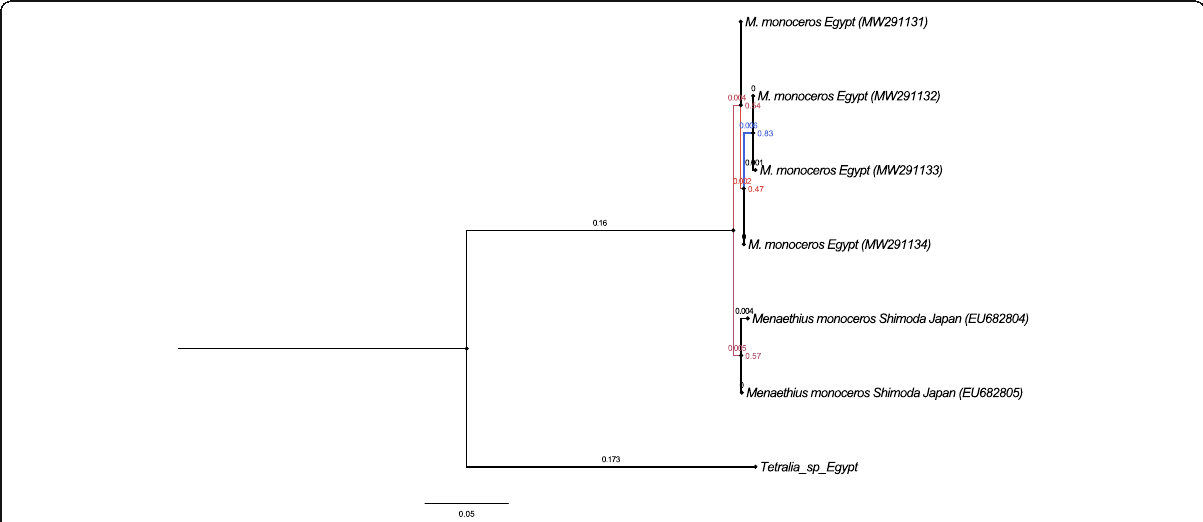
Fig. 4 Evolutionary relationships of taxa sequences with 16S marker using the Neighbor-Joining method with a bootstrap test (1000 replicates). Evolutionary distances were computed using the Kimura 2-parameter method; the rate variation among sites was modeled with a gamma distribution (shape parameter =